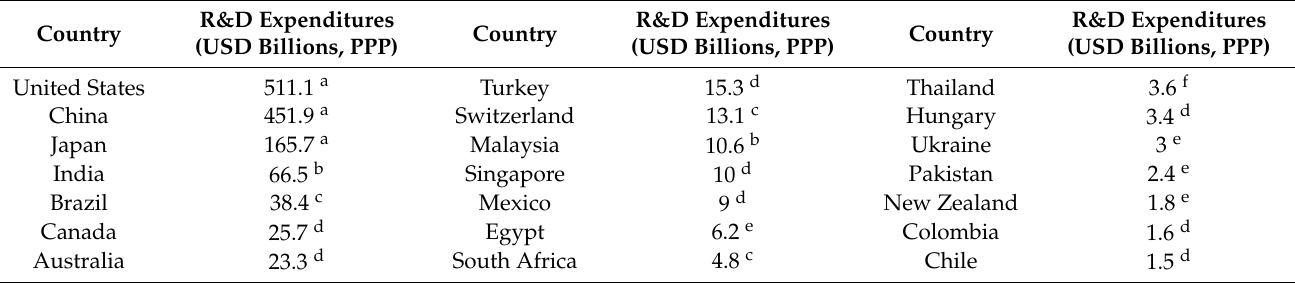
Table 1. List of Sample Countries by R&D Spending.